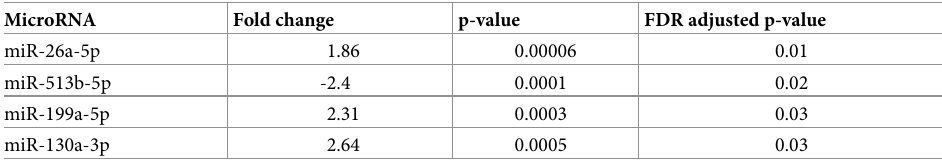
Table 2. MiRNAs with FDR adjusted p-value < 0.05.